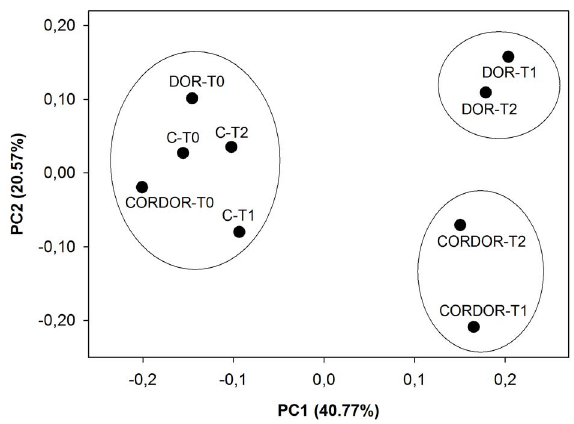
Figure 6. PCoA based on unweighted UniFrac distances of fungal community found in unamended soil (C) and soil amended with untransformed DOR (DOR) or C. floccosa – transformed DOR (CORDOR) at 0 (T0), 30 (T1) and 60 (T2) days. Percent variability explained by each principal coordinate is shown in parentheses after each axis